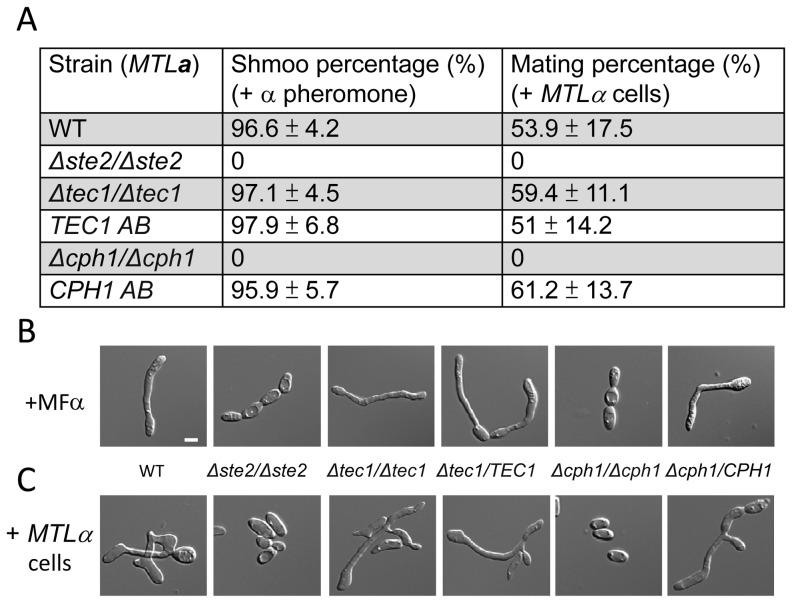
The formation of mating projections and a-α mating are mediated by the Cph1 transcription factor in opaque cells.(A) Deletion of STE2 or CPH1 abolished elongated projection formation and mating by C. albicans opaque cells. In contrast, TEC1 is not required for pheromone responses in the opaque state. Numbers are the mean ± SD from two independent experiments with three replicates. Images of (B) mating projections formed in MTL
a opaque cells responding to α pheromone, and (C) zygotes produced from mating between MTL
a and MTLα opaque cells. Scale bar: 5 µm. Each data point is the mean ± SD from two independent experiments with at least three replicates. (WT: CAY1477; Δste2/Δste2: CAY1478; Δtec1/Δtec1: CAY2689; TEC1 AB: CAY2775; Δcph1/Δcph1: CAY2947; CPH1 AB: CAY3046; MTLα: DSY211).